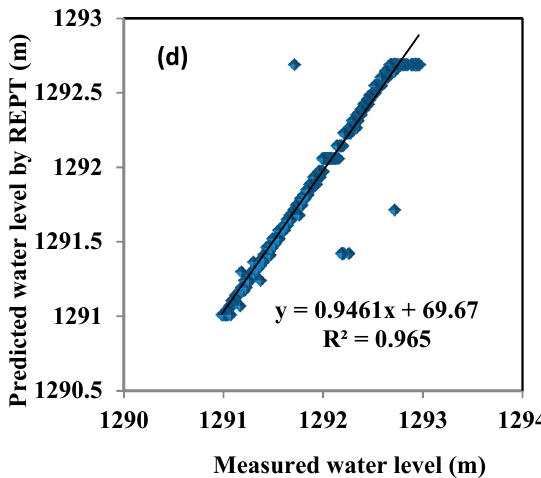
Figure 4. Scatter plots of observed vs. predicted water level (WL) s in the testing phase: ( a ) M5P; ( b ) RF; ( c ) RT; ( d ) REPT.